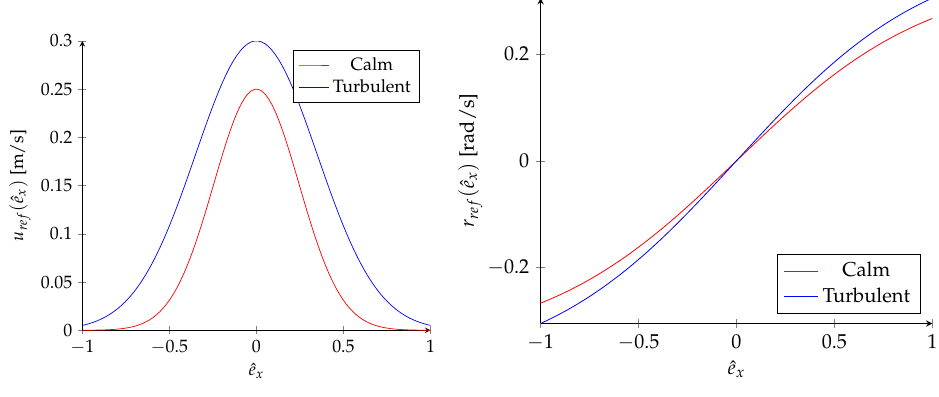
Figure 11. Surge speed ( left ) and yaw speed ( right ) curve used during autonomous docking. ˆ e x is the estimate of the x or horizontal image coordinate of the